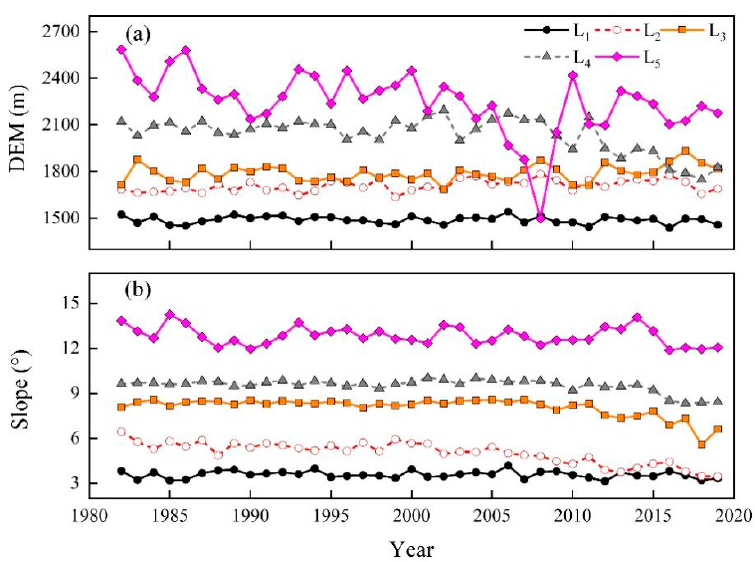
Figure 9. Spatial variation (elevation and slope) across all levels of the normal difference vegetation index (NDVI) of the Yellow River Basin (YRB). ( a ) Elevation (m) and ( b ) slope (°). L 1 –L 5 represent the following NDVI levels, respectively: <0.2, 0.2–0.4, 0.4–0.6, 0.6–0.8, and >0.8. DEM: digital elevation model. Table 4. Mean elevation and slope of all levels of NDVI in each sub-basin.